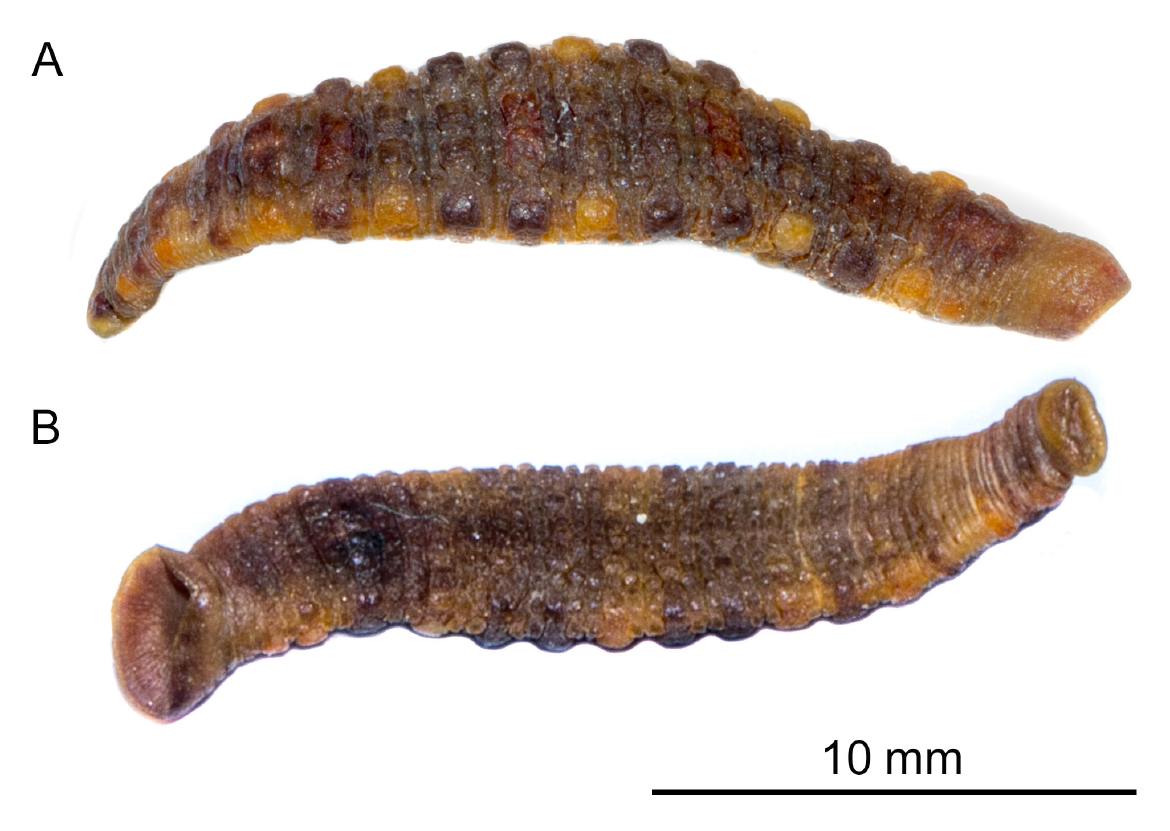
Figure 1. Pontobdella macrothela removed from a Carcharhinus amblyrhynchos host and photographed after preservation in alcohol. Note the distinctive eye spots present on dorsal view in A